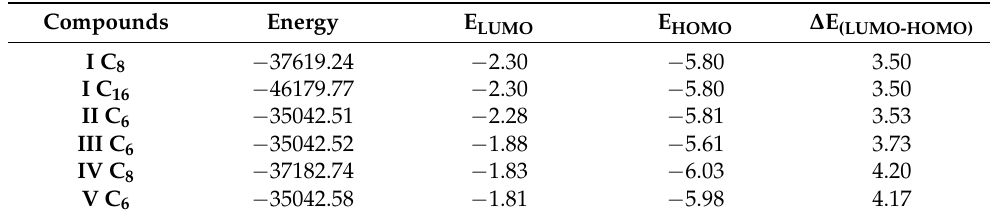
Table 4. The energies (eV), molecular orbitals energies (eV) of compounds I C 8 , I C 16 , II C 6 , III C 6 , IV C 8 , and V C 6